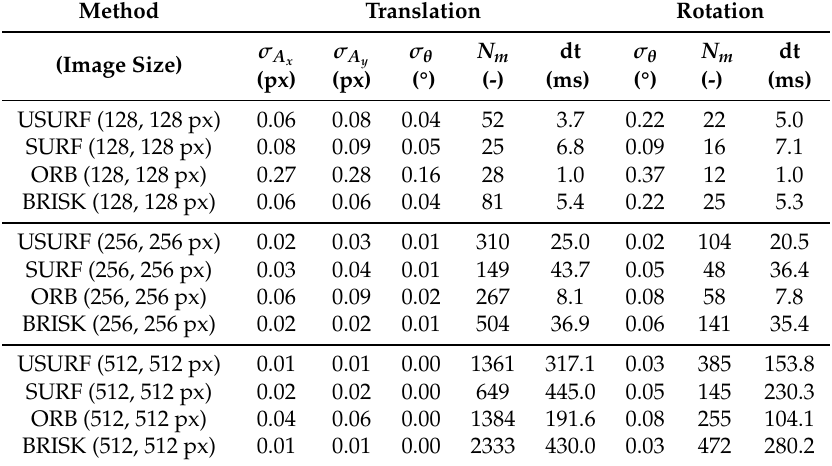
Comparison of the measurement precision, the number of features matched ( N m ), and processing times using an Intel i5-4590 CPU (dt) for different window sizes. One standard deviation errors ( σ A , σ A , and σ θ ) are calculated for translation measurement via comparison with x y normalised cross-correlation results and zero rotation, and for rotation measurements ( σ θ only) by comparison with applied stage